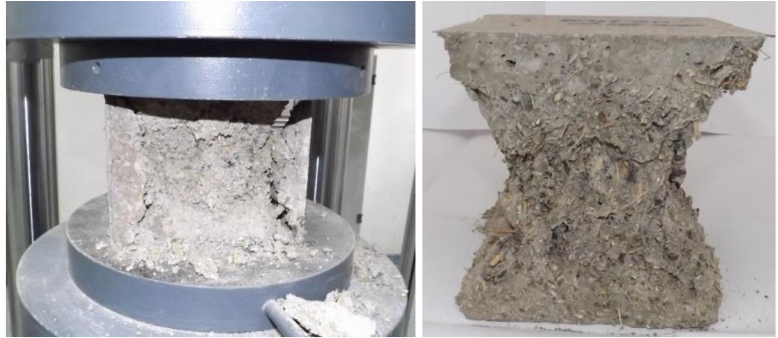
Figure 4. Compressive strength testing.